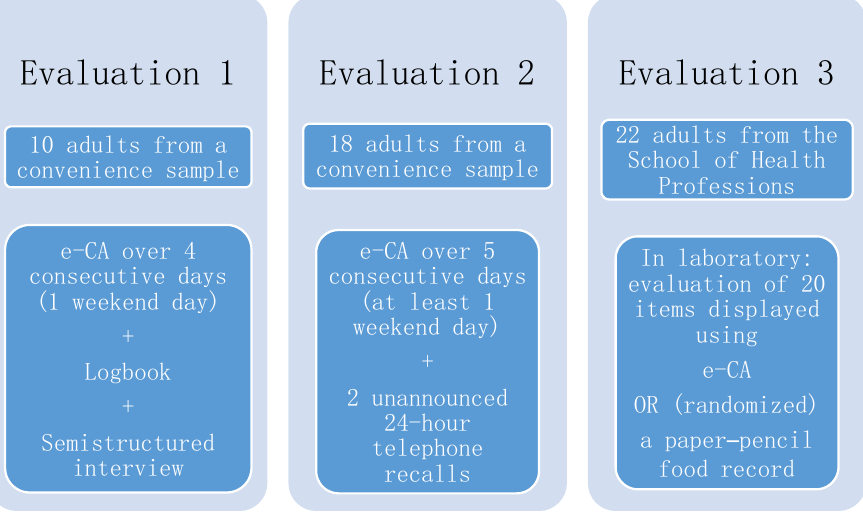
Figure 1. Illustration of the three steps for evaluating the electronic food record